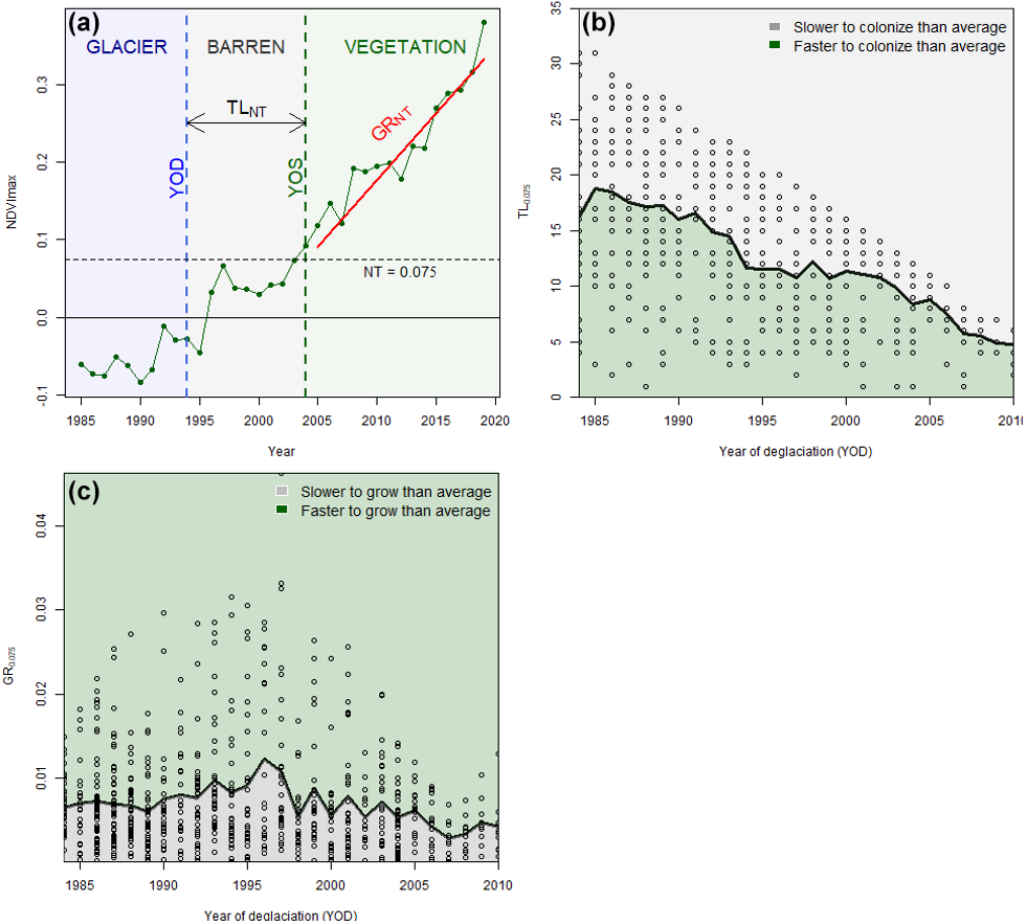
Figure 3. (a) Example of indicators derived from the Landsat-based NDVImax time series and deglaciation data for a single pixel located in the Glacier Blanc forefield (44 ◦ 55 (cid:48) 58.5768 (cid:48)(cid:48) N, 6 ◦ 24 (cid:48) 34.8516 (cid:48)(cid:48) E). (b) Time lag (TL) and (c) growth rate (GR) for an NDVI threshold of 0.75 for the eight margins according to year of deglaciation. Thick black lines represent the median value for each year of deglaciation used to compute anomalies. Green-shaded areas represent faster colonization and growth rate than average, while slower than average growth rates are indicated by gray-shaded